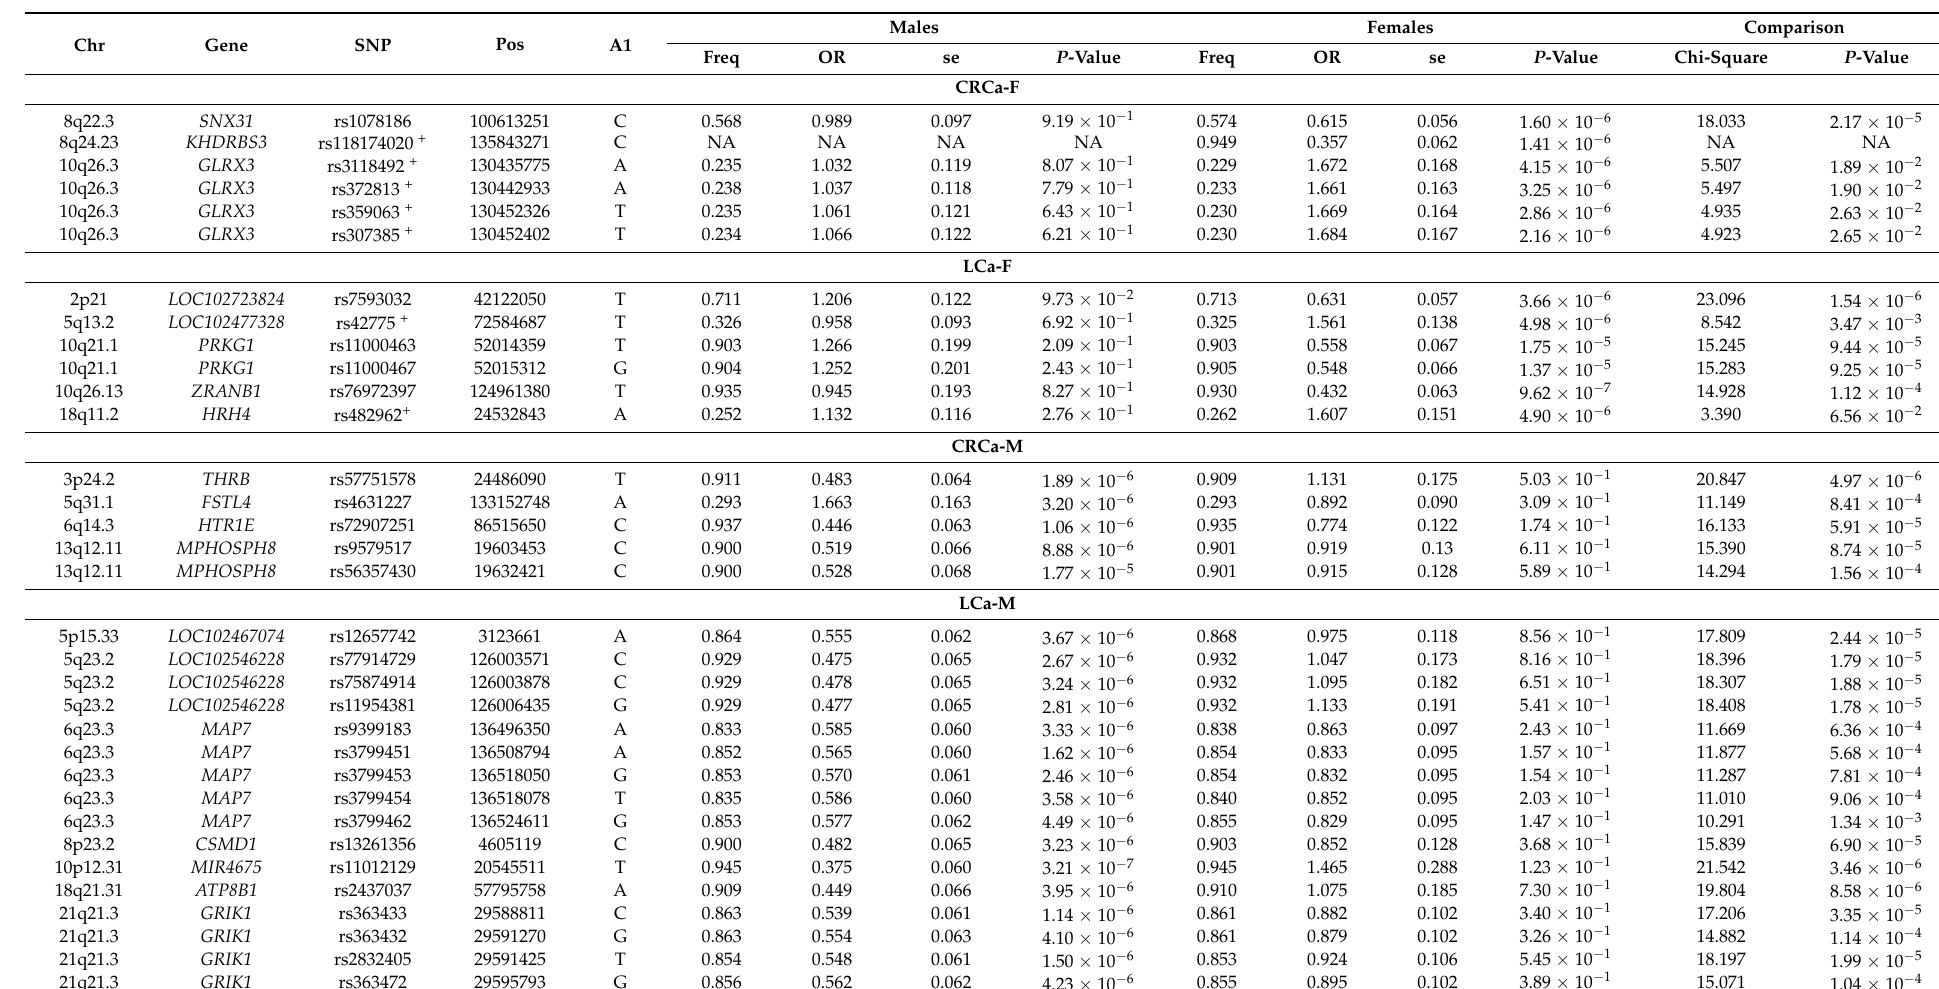
Table 2. Wald’s Chi-square test to compare odds ratios of detected cancer-associated SNPs between males and